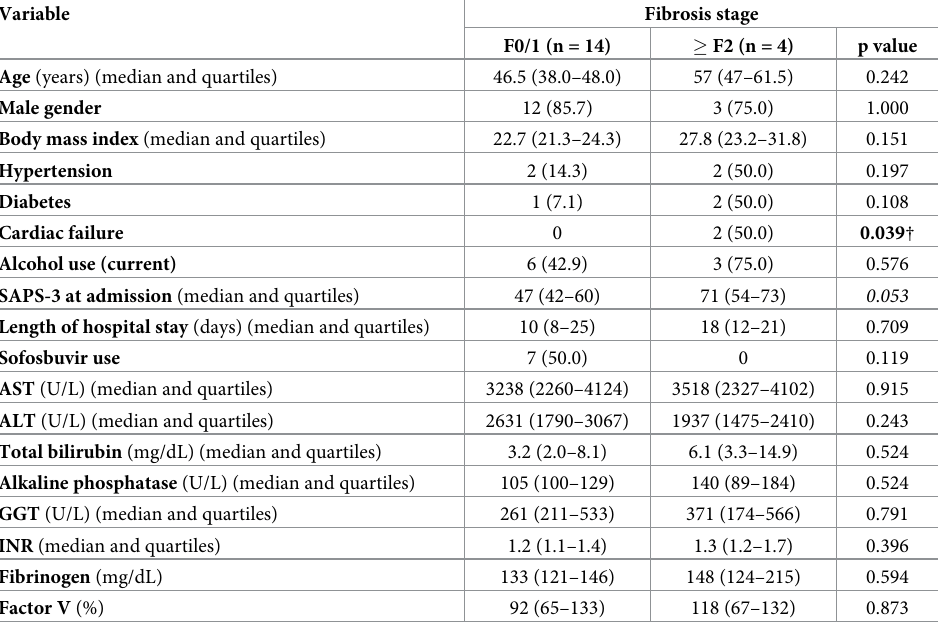
†Statistical significance. SAPS-3, Simplified Acute Physiology Score 3. AST, aspartate aminotransferase. ALT, alanine aminotransferase. GGT, gamma-glutamyl transferase. INR, international normalized